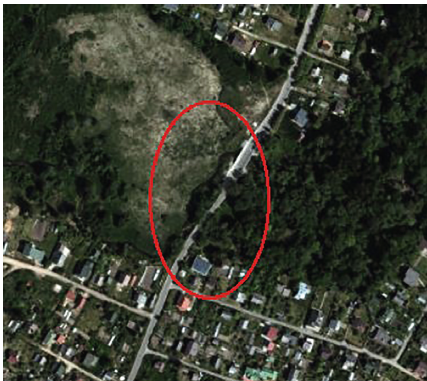
Figure 4: Analysed river section in the digital raster orthopho- tographic map (source: